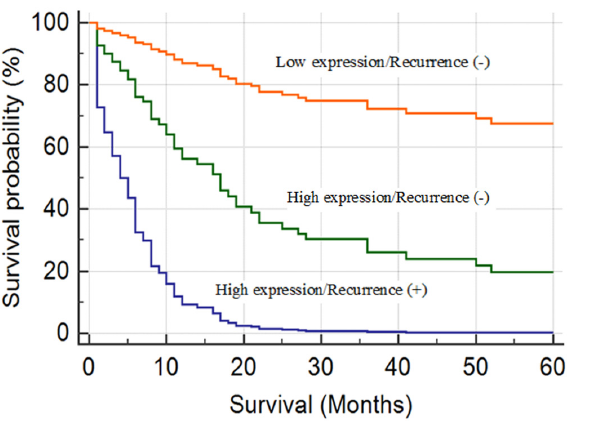
Figure 8. Heat shock-related 70-kDa protein 2 expression/recurrence status (Cox regression